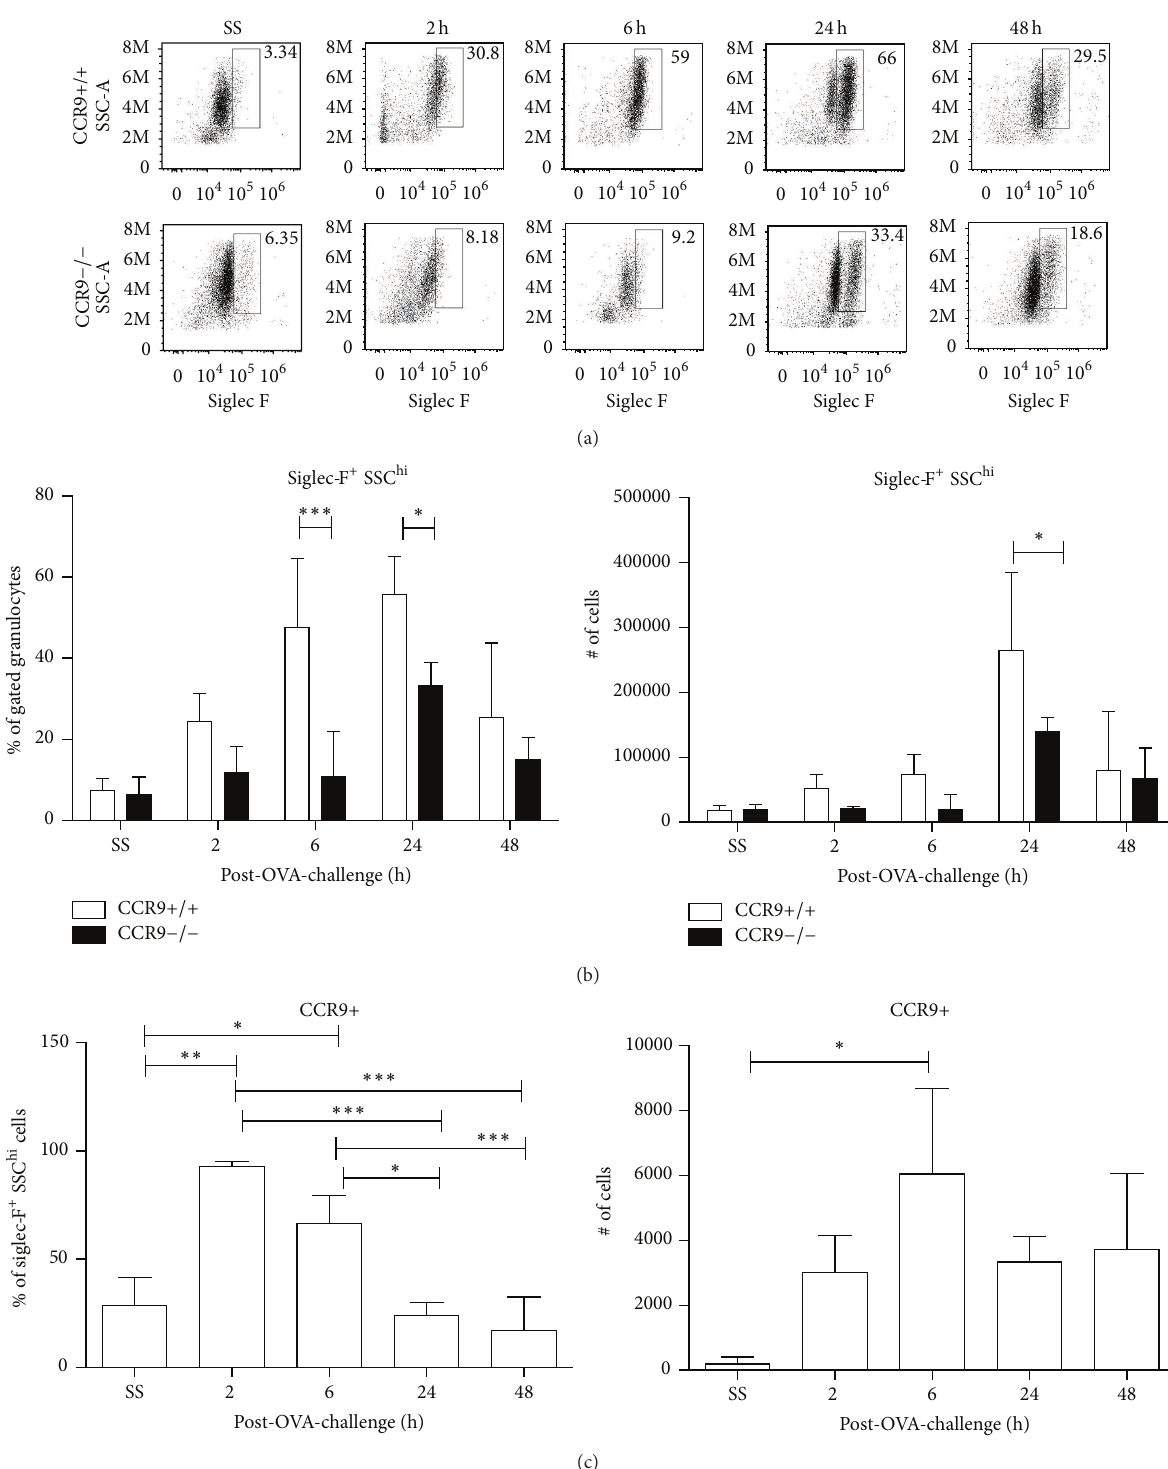
Figure 6: CCR9 expression in eosinophils regulates their recruitment to inflamed lung. 2, 6, 24, and 48 h after the last OVA boost, BALF from OVA-sensitized/challenged mice was collected and analyzed by FACS. (a) Siglec-F + SSC hi cells were plotted. (b) Quantitation of eosinophils in WT and KO mice during inflammation. (c) Percentage and CCR9-expressing eosinophils in WT mice. Data are representative of 2 independent experiments and represent mean ± SD. 𝑛 = 3 –5 for each group ( ∗ 𝑝 < 0.05 , ∗∗ 𝑝 < 0.01 , and ∗∗∗ 𝑝 < 0.001 when compared with WT mice or when compared each time with control